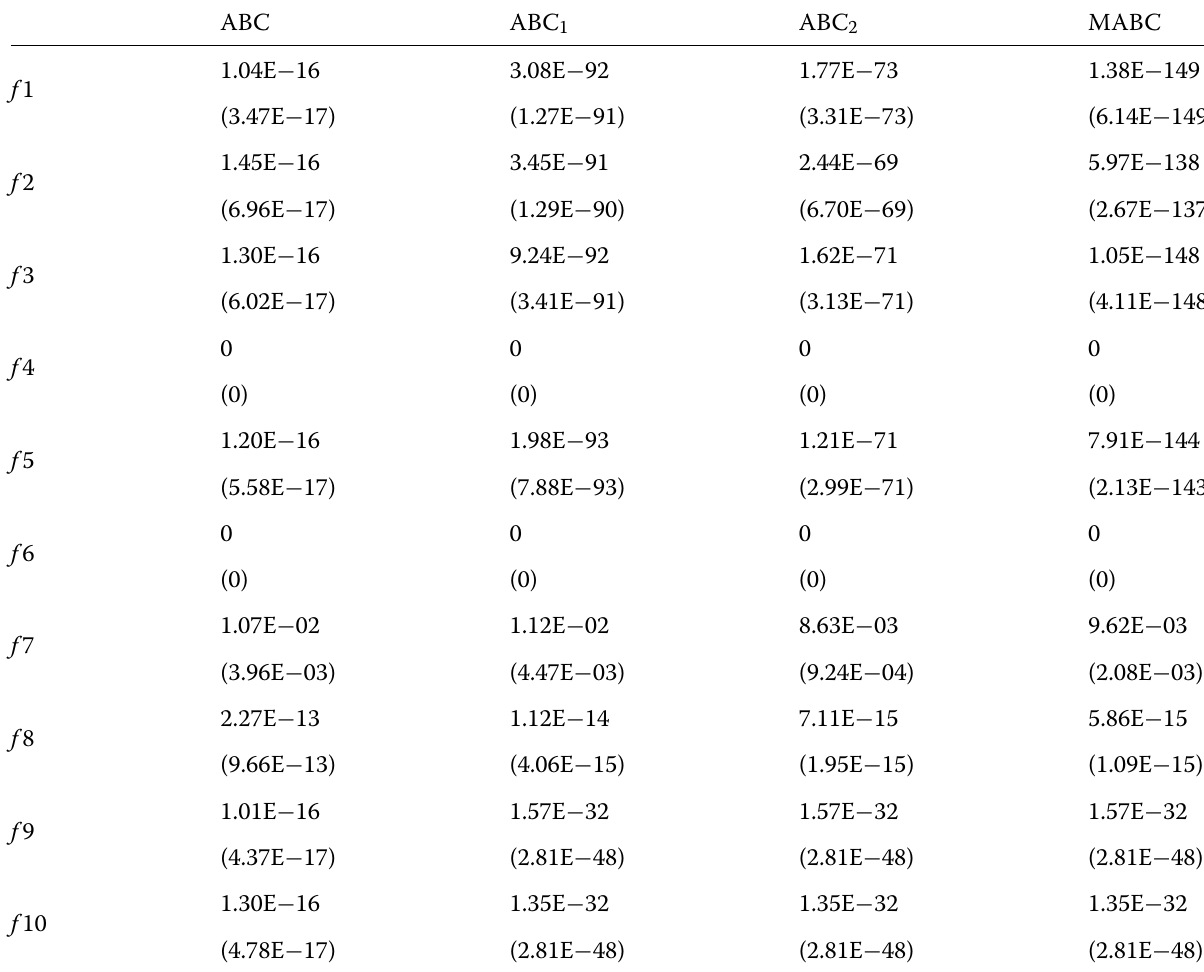
Table 11 Comparison results for ABC, ABC 1 , ABC 2 , and MABC